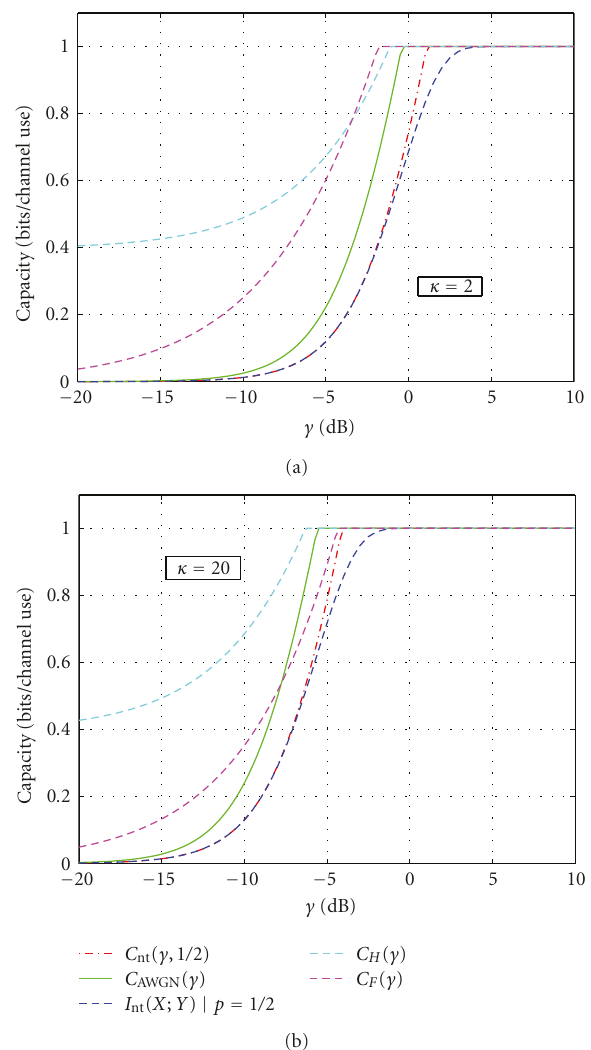
Figure 1: Capacity bounds and mutual information numerically solved for the nonturbulent optical channel with uniform input distribution when a rectangular pulse shape with duty cycle of 100%, that is, ξ = 1, and values of (a) κ = 2 and (b) κ = 20 are